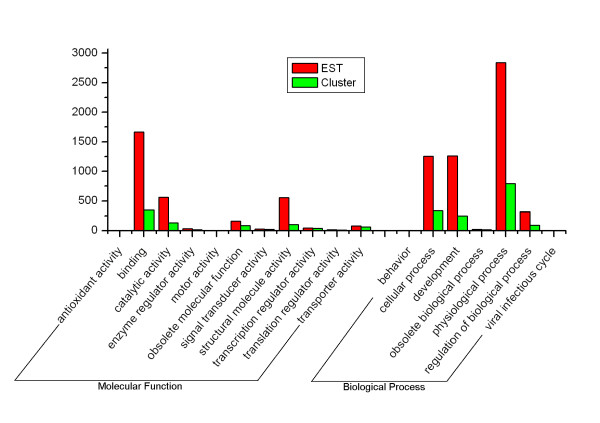
Functional classification of transcripts in the venom gland of D. acutus according to molecular function and biological process based on Gene Ontology. The vertical axis shows the number of EST or cluster.